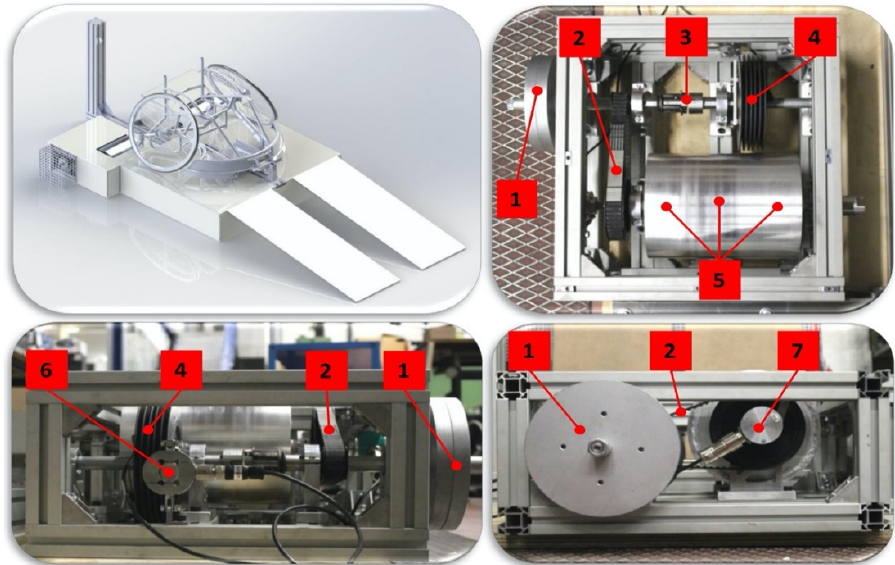
Figure 1. Non-motorized ergometer employed in the tests. Numbers are referred to: Inertial disks ( 1 ); transmission belt ( 2 ); mechanical coupling ( 3 ); electromechanical brake ( 4 ); drum ( 5 ); load cell ( 6 ); encoder ( 7 ).